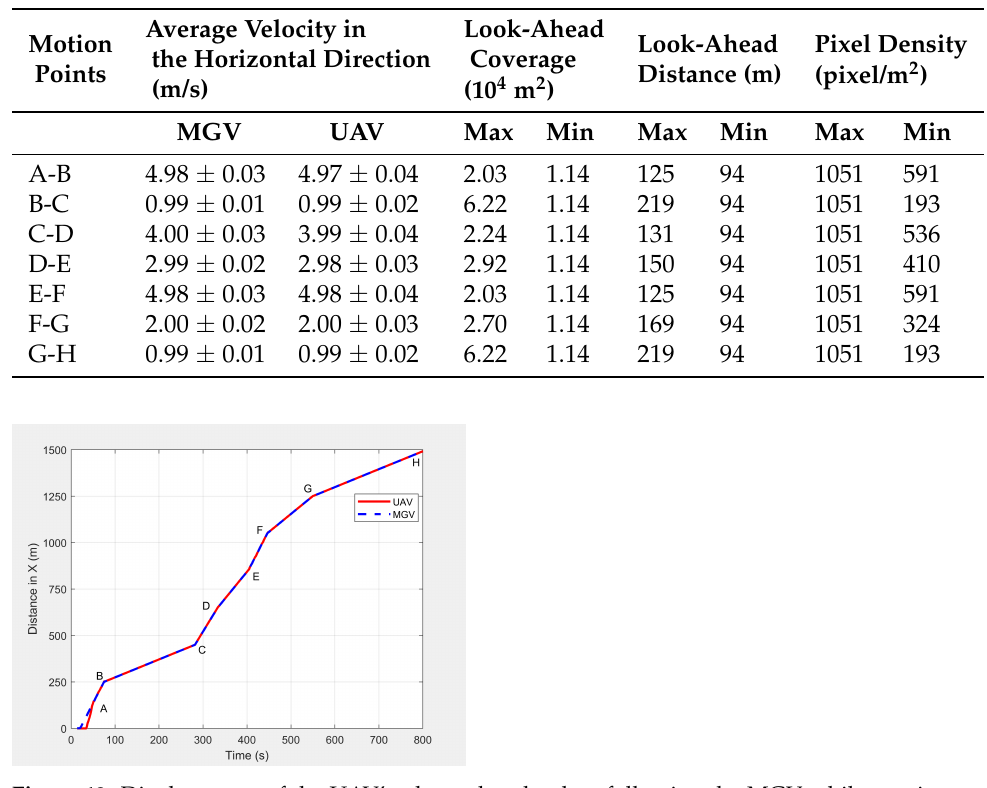
Figure 13. Displacement of the UAV’s planned path when following the MGV while moving at a varying velocity.